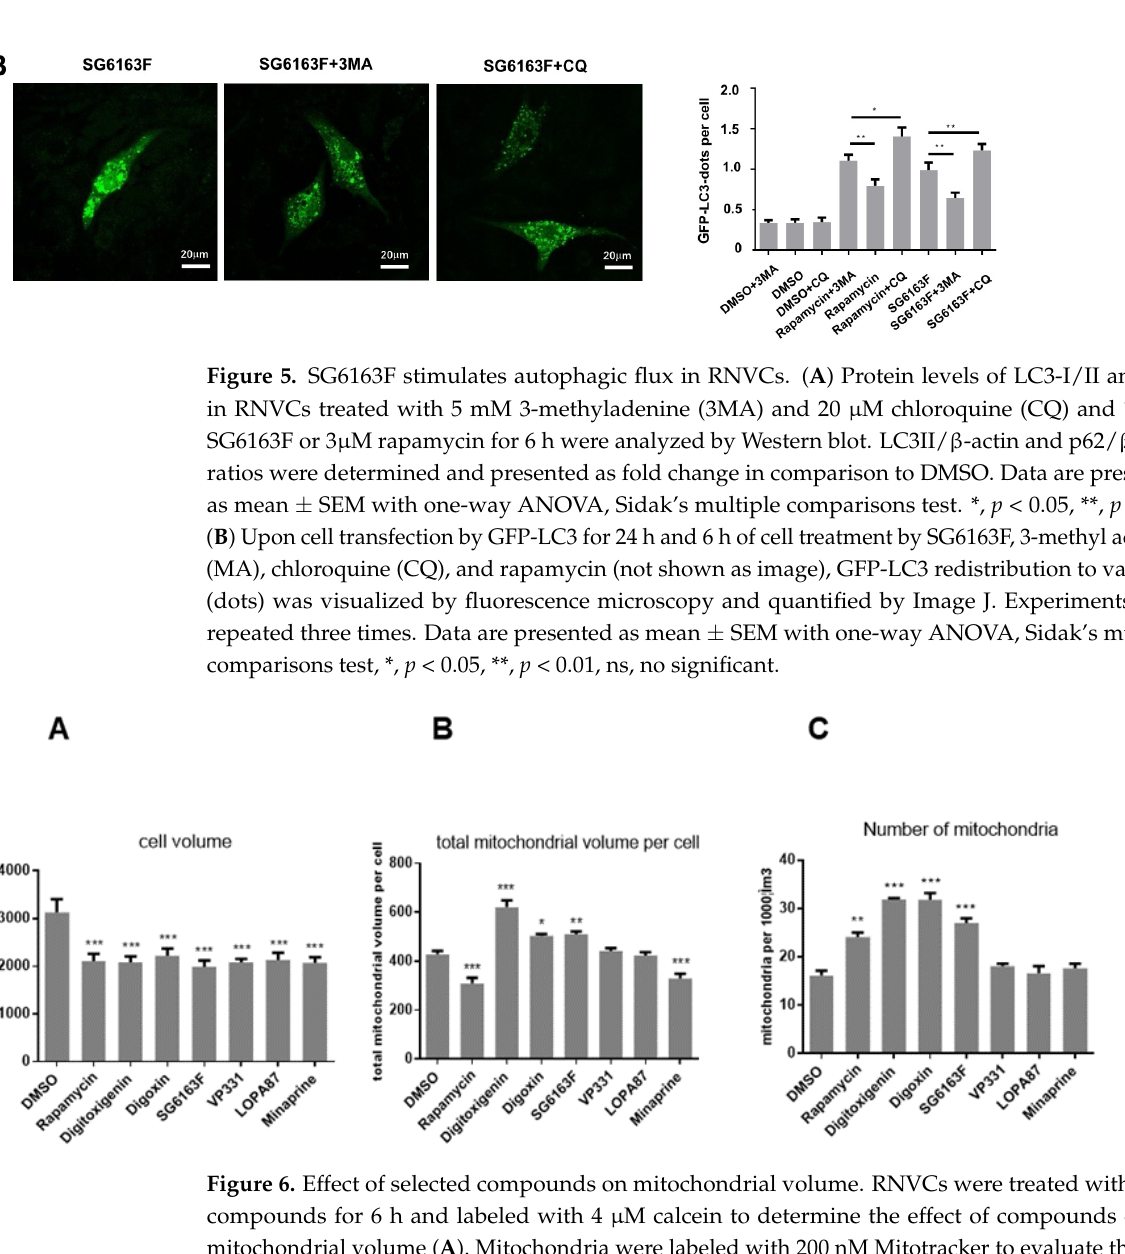
Figure 7. Effects of compounds on the expression of proteins of the mitochondria fusion/fission ma- chinery. ( A ) Following RNVCs incubation with 1 µM of indicated compounds, expression was an- alyzed by Western blot. The intensities of MFN1 and MFN2 bands were normalized to β -actin. ( B ) Drp-1 and p -Drp-1 expressions in treated RNVCs were analyzed by Western blot and their ratio quantified. Experiments were repeated 3 times. Representative Western blot images and quantifica- tion of three independent experiments are presented as mean ± SEM with one-way ANOVA, Sidak’s multiple comparisons test. *, p < 0.05, **, p < 0.01, ***, p < 0.001 vs. DMSO. In digoxin and SG6163F- treated cells, numerous short and round mitochondria can be observed compared to 0.1% DMSO-treated cells (controls), which have long and thin mitochondria (Figure 8). Thus, transmission electron microscopy confirms that mitochon- dria are smaller in H9c2 cells treated with 10 µM SG6163F and 1 µM digoxin in compari- son to cells treated with DMSO or 1 µM SG6163F.